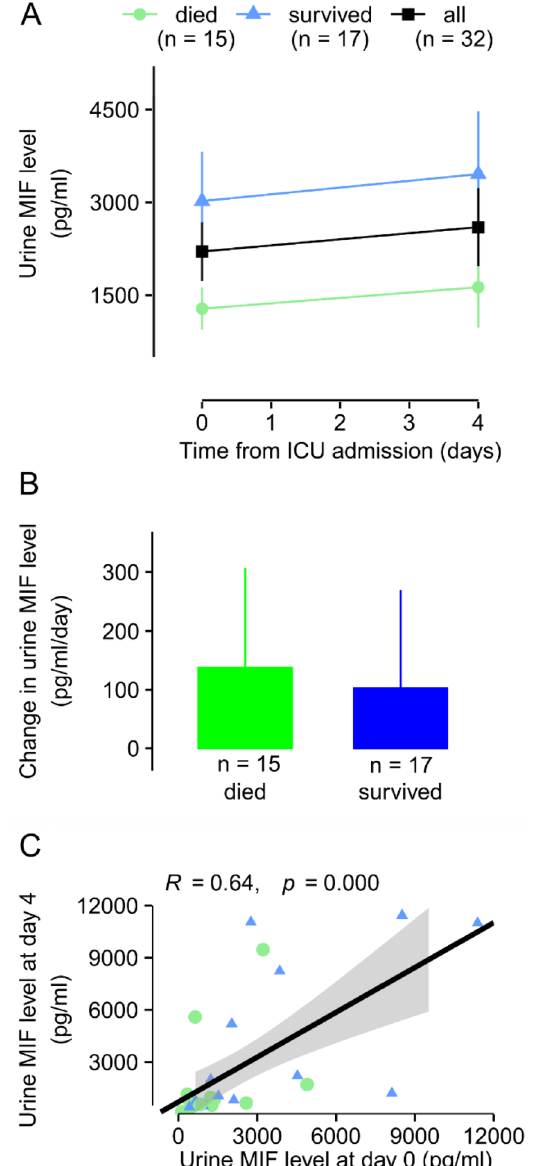
Figure 5. The kinetics of urine macrophage migration inhibitory factor (MIF) levels in septic patients at the intensive care unit (ICU). ( A ) The mean absolute urine levels of MIF in all, deceased, and survived septic patients on day 0 and 4 from admission to the ICU. ( B ) The mean daily changes of urine MIF levels in deceased and survived patients. ( C ) The correlation between urine MIF levels measured on day 0 and on day 4 from the admission to the ICU. The number of patients (n) is indicated in the figure in each